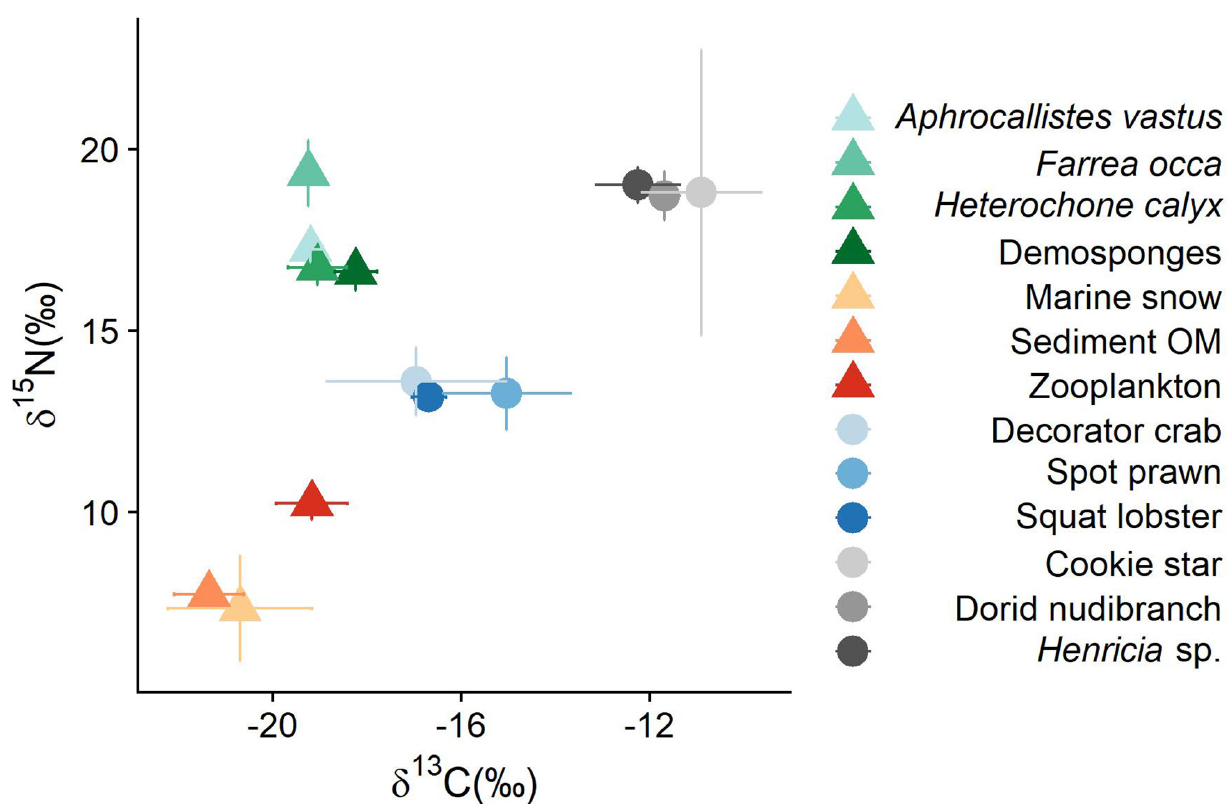
FIGURE 2 | Isospace plot for all sources and consumers sampled in this study. Raw data can be found in Supplementary Table S6 . Error bars represent standard error.